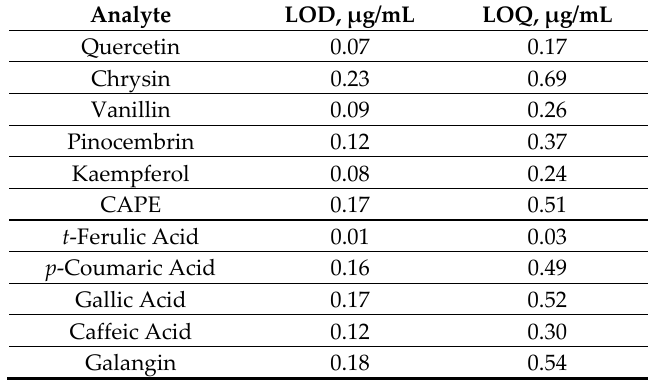
Table 4. Limit of quantitation (LOD) and limit of detection (LOQ) calculated for analytes of